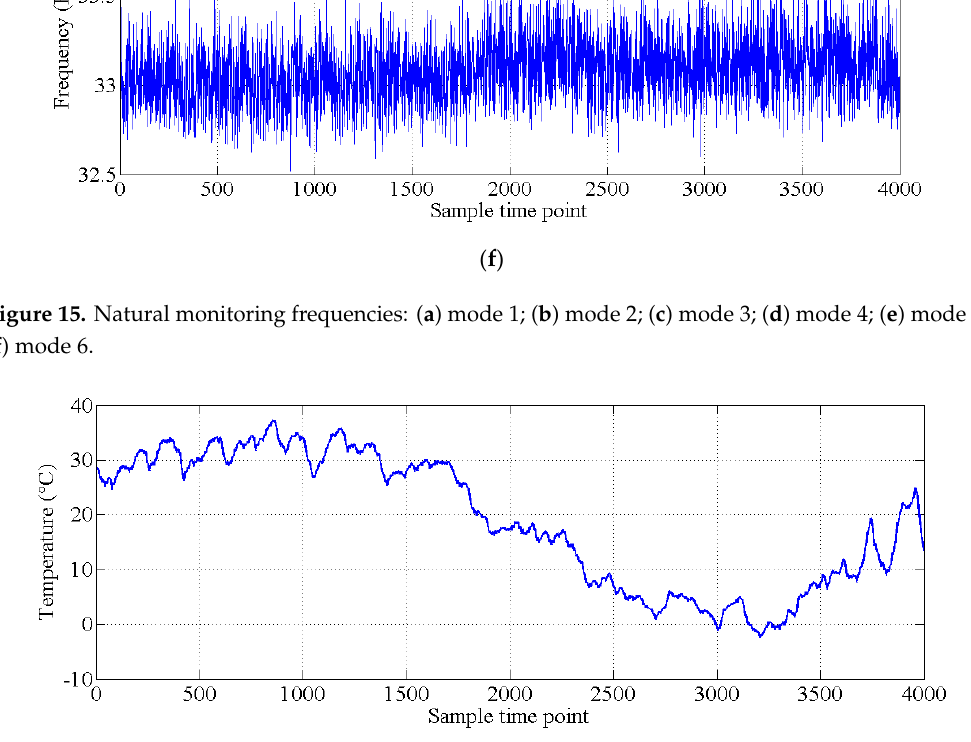
Figure 16. Environmental temperature monitoring data.